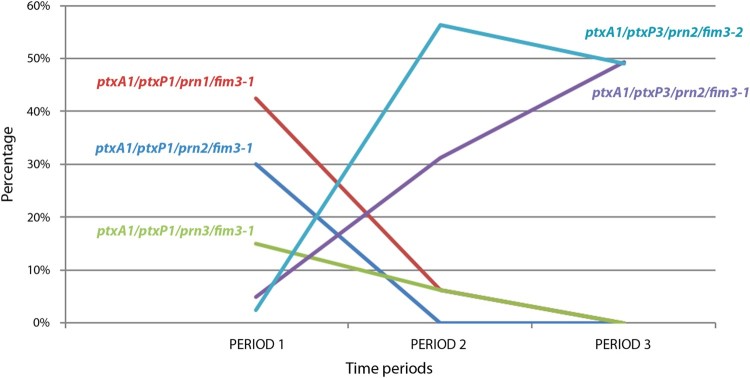
Temporal evolution of the most prevalent antigenic profiles observed in B. pertussis circulating in the metropolitan area of Barcelona from 1986 to 2015. Period 1: exclusive use of whole cell vaccine; Period 2: transition from whole cell vaccine to acellular vaccine; Period 3: exclusive use of acellular vaccine.